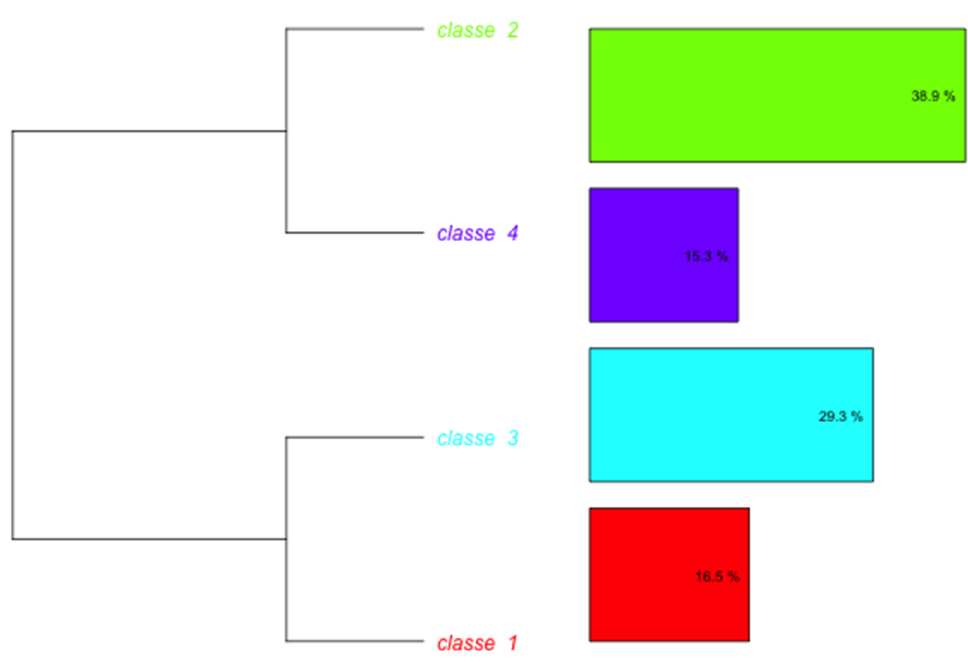
Figure 4. Dendrogram—second interview—parents.